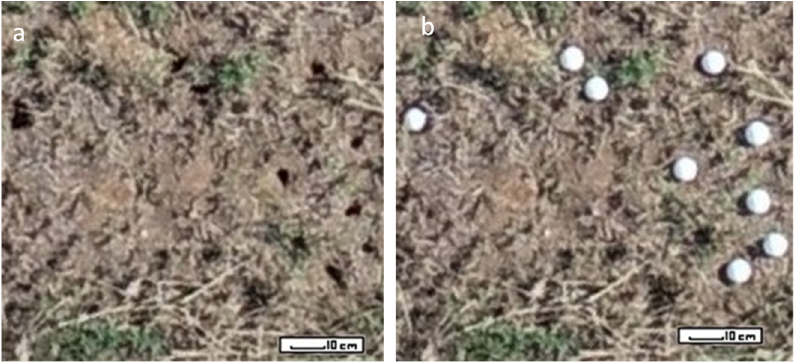
Figure 5. External validation test data were collected via UAS before ( a ) and after ( b ) marking burrows with white Styrofoam balls.